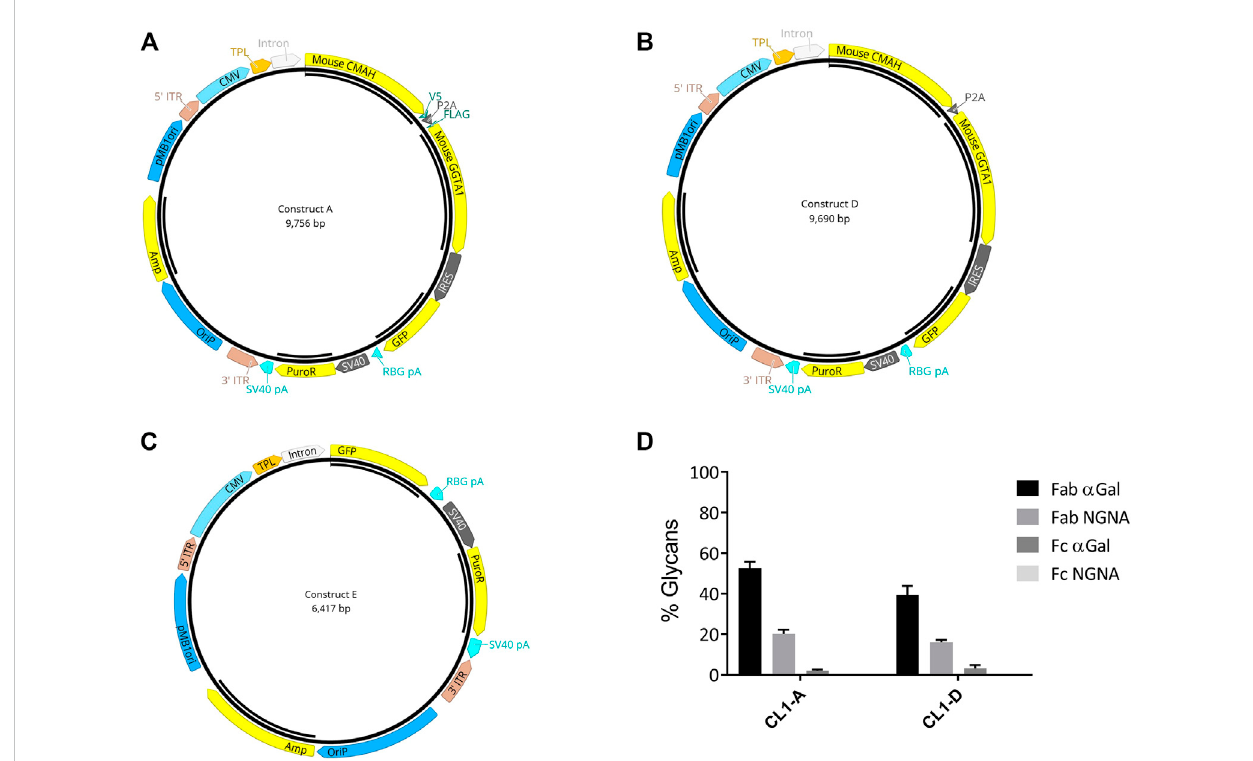
FIGURE 2 Strategyforbiosimilarcelllinedevelopment.BothconstructsAandDcontainmouseCMAHandGGTA-1.Thetwogeneswerejoinedbythefurin2A self-cleavingpeptide. (A) InConstructA,CMAHwasfusedwithaC-terminalV5tagandGGTA1wasfusedwithanN-terminalFLAGtag.Green fl uorescent protein(GFP) witha5 ′ IRES(internalribosomeentry site) wasincorporated inConstructs Aand D. (B) Construct Dwassimilar toConstruct AwithoutFlag andV5 tags. (C) Construct Ewasengineeredto express GFPonlyas control. (D) LC-MS/MS analysis wasperformedto determine theglycan pro fi les (%glycans) from day 10 fed-batch harvest samples from the cell pools generated by transfection of constructs A and D (CL1-A and CL-D) respectively. Selective glycans-Fab α Gal, Fab NGNA, Fc α Gal, and Fc NGNA are shown. percent change of % relative glycans Fab ( α -Gal and NGNA) and Fc ( α -Gal and NGNA) when compared to CL1-E control pools. The error bars of the percent changes were derived from the relative errors of control and pools generated from different transfections of individual vectors ( N =